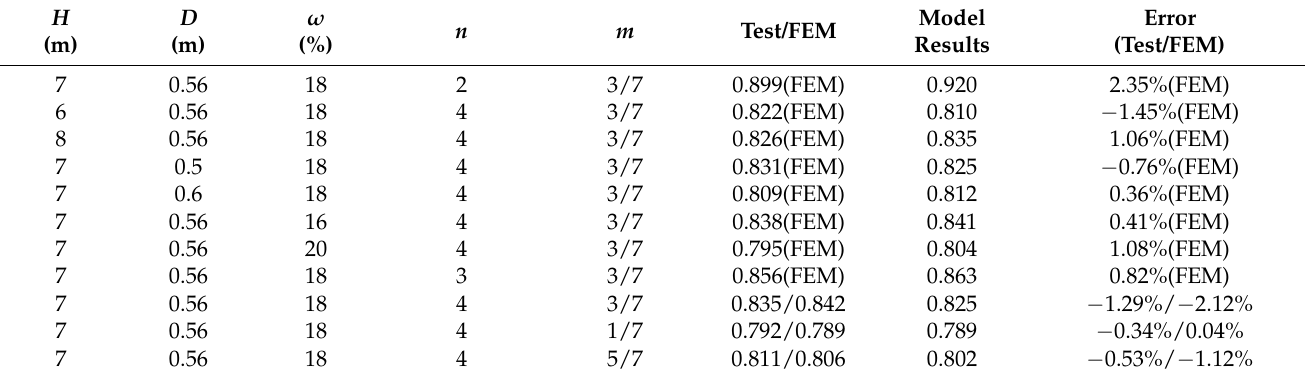
Table 6. Comparison between model results and test and numerical results at the edge